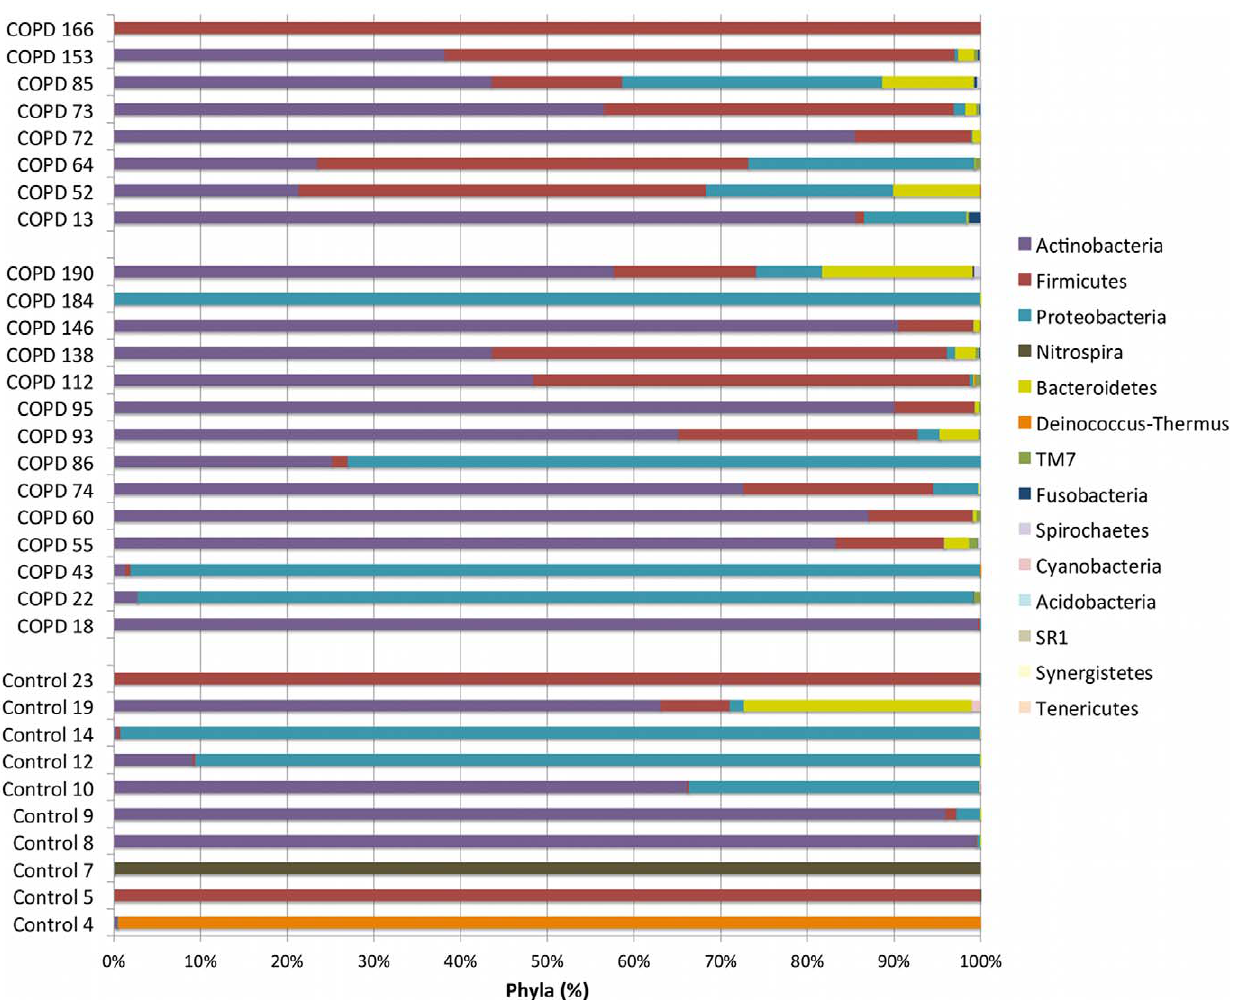
Figure 1. Taxonomic Identification at the Phylum Level. All sequences were submitted to RDP Classifier for taxonomic identification with a bootstrap cutoff of 50%. Taxonomic results at the phylum level are displayed for each sample with Control samples at the bottom, Moderate COPD samples in the middle, and Severe COPD samples at the top. The legend is organized from most (top) to least abundant (bottom) phyla.